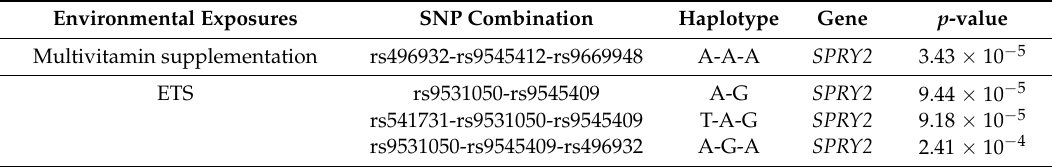
Table 2. The haplotypes in SPRY genes showing significant interactions with environment exposures among 806 Chinese NSCL/P trios after Bonferroni correction 1